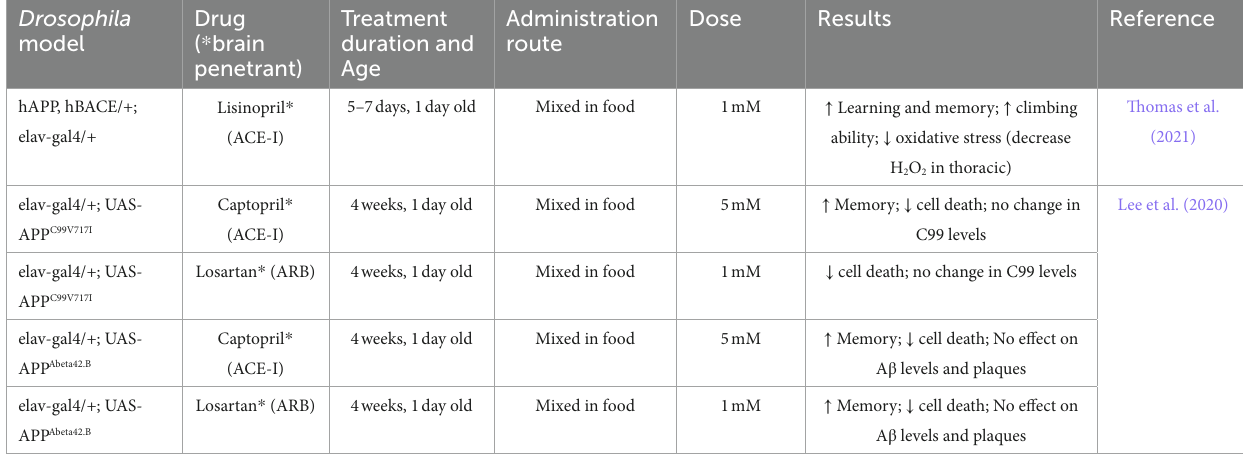
Drugs marked with ( * ) indicate BBB penetrance. TABLE 3 Summary of effects of ACE-Is and ARBs in Drosophila models of AD including A β levels and deposition, oxidative stress and, cognitive deficits. Drosophila